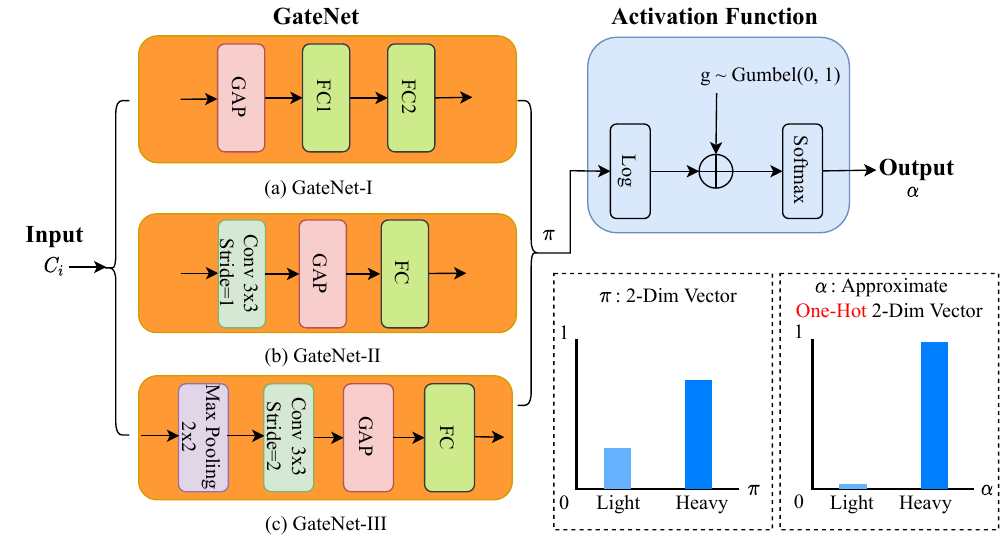
Figure 4. The three different architectures of Gating Network GateNet. ( a ) The computational cost of the GateNet-I is about 1 of the Light Path. ( b ) GateNet-II contains a Convolutional layer and H o × W o has a computational cost about 10 times of the Light Path. ( c ) GateNet-III includes one Pooling layer and has similar computational cost to the Light Path. In addition, a Gumbel–Softmax function is utilized to convert π to an approximate one-hot vector α